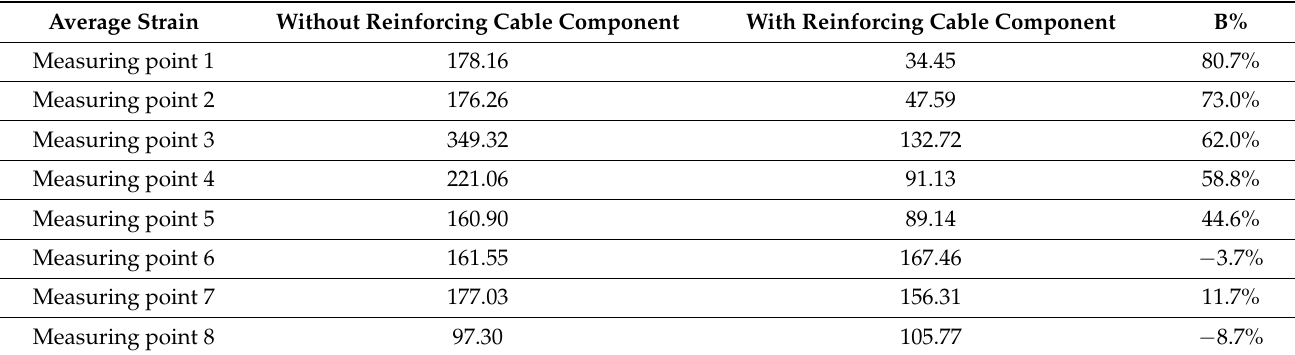
Table 5. The strain reduction comparison of measuring